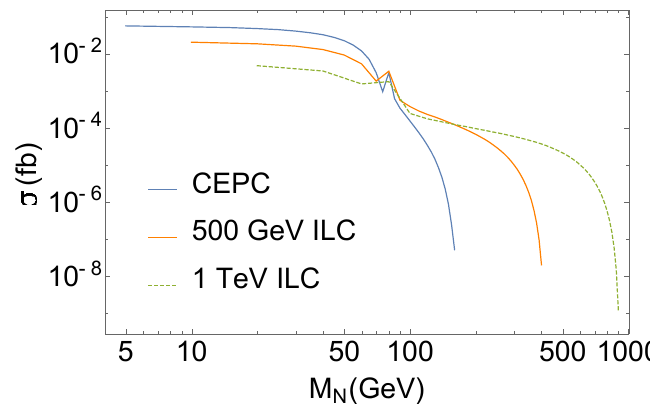
Figure 3 . Total cross section for the process e + e (cid:0) ! N(cid:22) (cid:6) W (cid:7) ! (cid:22) (cid:6) (cid:22) (cid:6) + 4 j at the CEPC and ILC (500 GeV and 1 TeV), with S (cid:22)(cid:22) = 10 (cid:0) 4 .